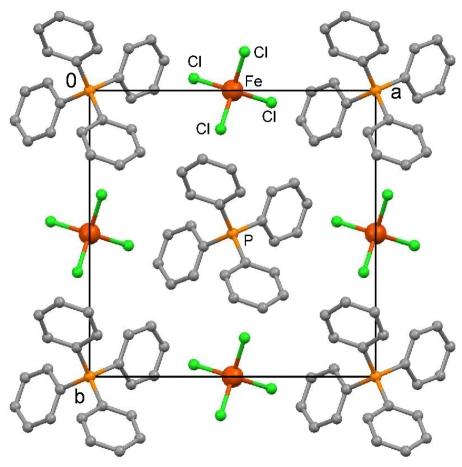
View of the crystal packing in (Ph4P) (FeCl4) in the direction of the crystallographic c axis at 123 K. Fe-Cl bond length 2.1939(5) Å, Cl-Fe-Cl angles 105.51(2) and 113.47(3)°. All hydrogen atoms were omitted for clarity.